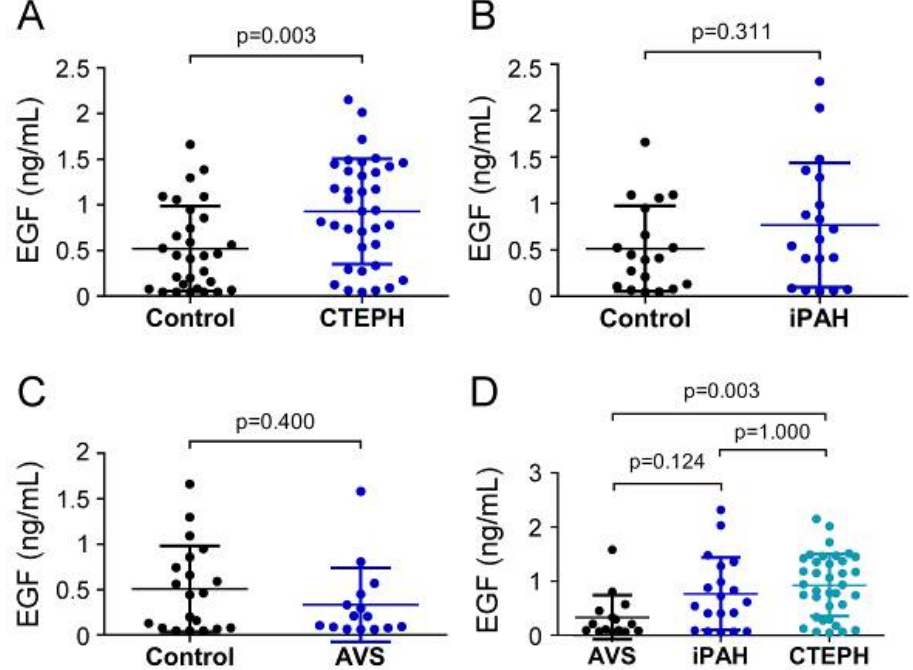
Figure 3. Serum concentrations of EGF in ( A ) CTEPH, ( B ) iPAH, and ( C ) AVS patient groups and controls. ( D ) Comparison of EGF levels between AVS, iPAH, and CTEPH patients. Each dot repre- sents one donor. Arithmetic means and standard deviations are indicated by horizontal lines. Pa- tient groups were compared to controls by Mann–Whitney U test. One-way ANOVA with Bonfer- roni–Holm post hoc test was used to compare 3 groups.